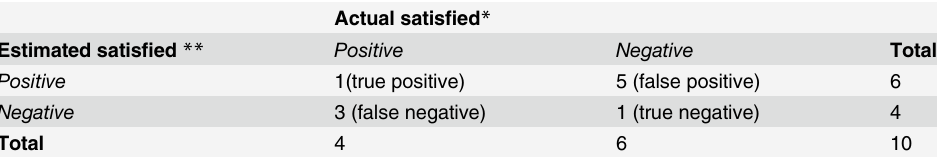
Table 4. Two-by-two matrices of the relationship between the estimated dissatisfied and the actual dissatisfied (sensitivity analysis).